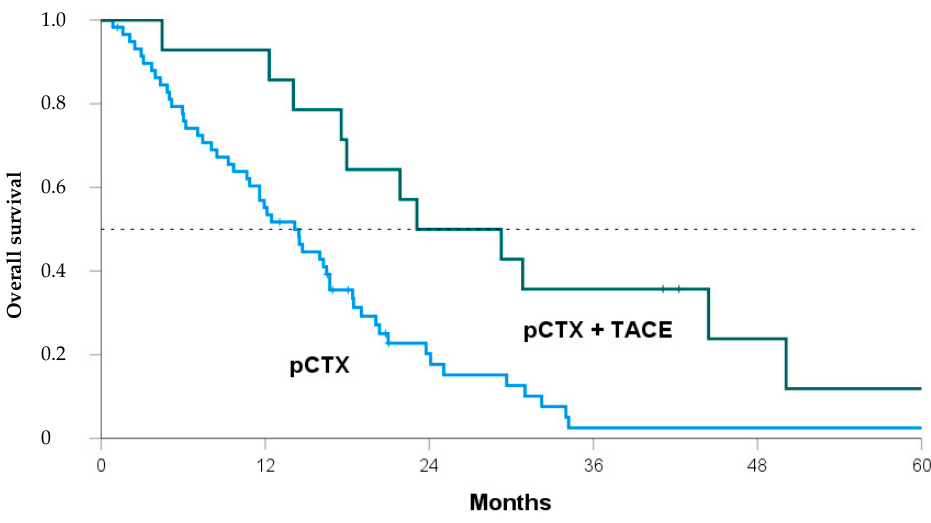
Figure 2. Kaplan-Meier curve comparing overall survival of patients from the time of unresectability treated with either both transarterial chemoembolization and palliative chemotherapy (pCTX + TACE, green line) or pCTX alone (blue line). Log Rank p = 0.005.